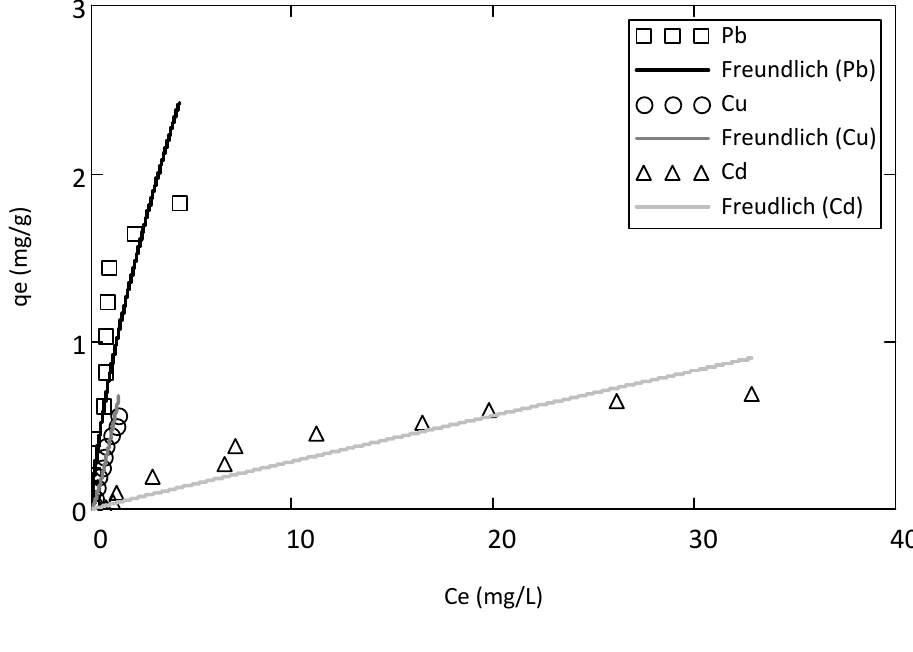
Figure 3. Freundlich adsorption isotherm for Pb 2+ Cu 2+ and Cd 2+ on the studied soil at pH